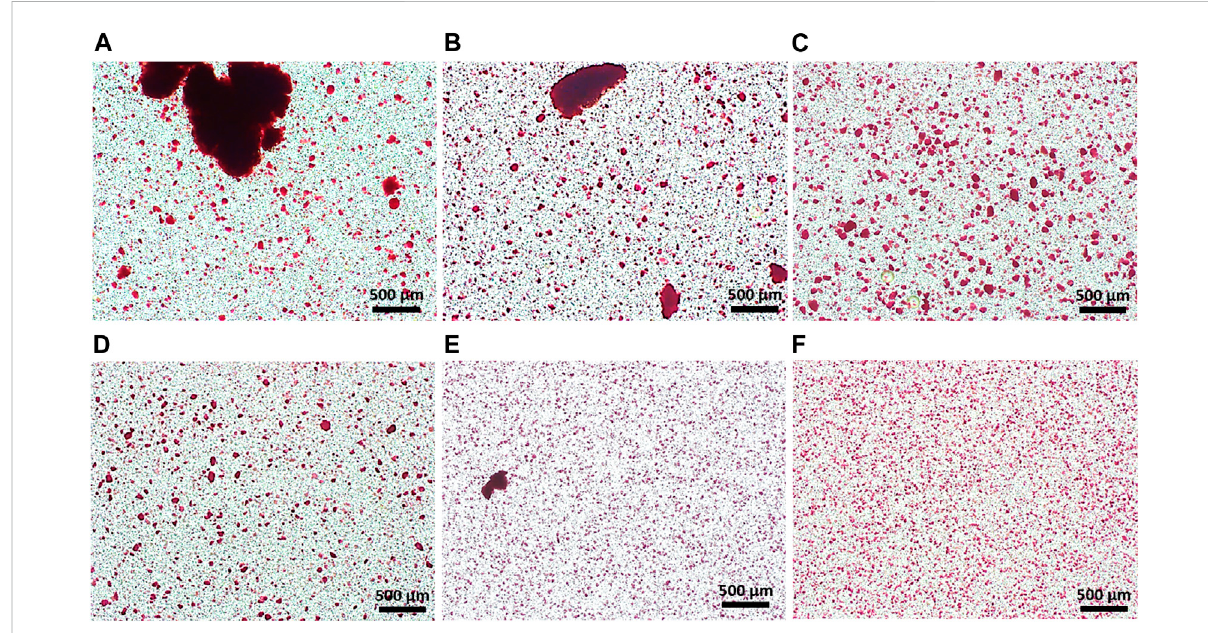
FIGURE 1 HomogeneityofHAp powderinalginatesolution;stirringfor (A) 6 minand (B) 21 min;planetarycentrifugal mixingfor (C) 6 minand (D) 21 min;